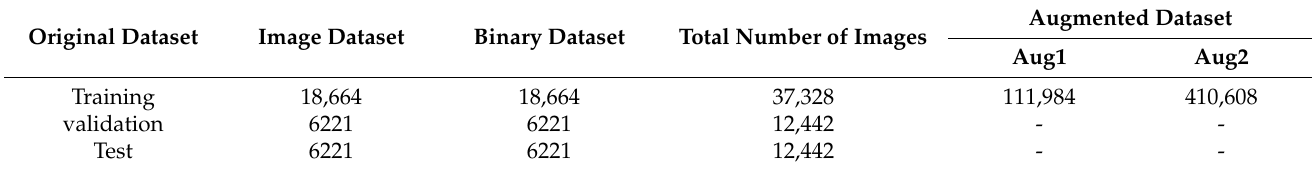
Table 3. The number of image datasets for deep learning analysis.